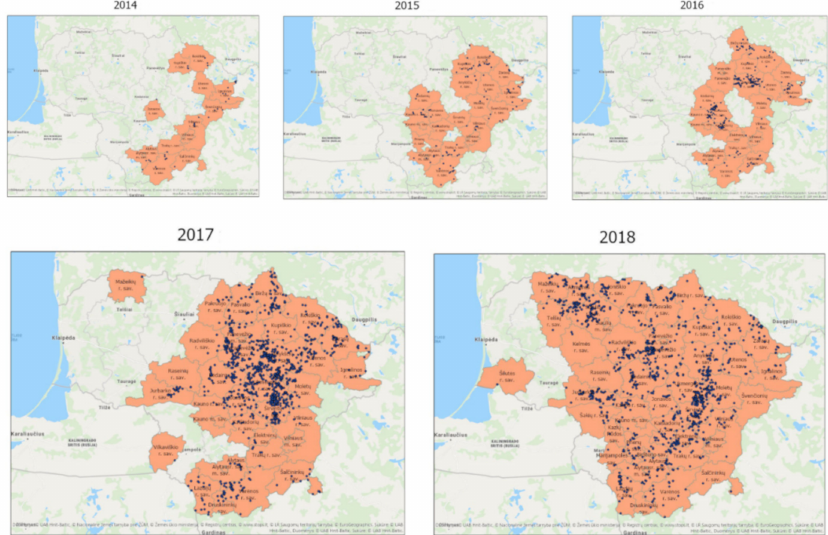
Figure 6. ASF spread in Lithuania (2014–2018). A ff ected municipalities and elderships are marked in orange. Positive cases in wild boar are indicated as blue dots. As soon as one case occurred within a year, the respective municipality was regarded as a ff